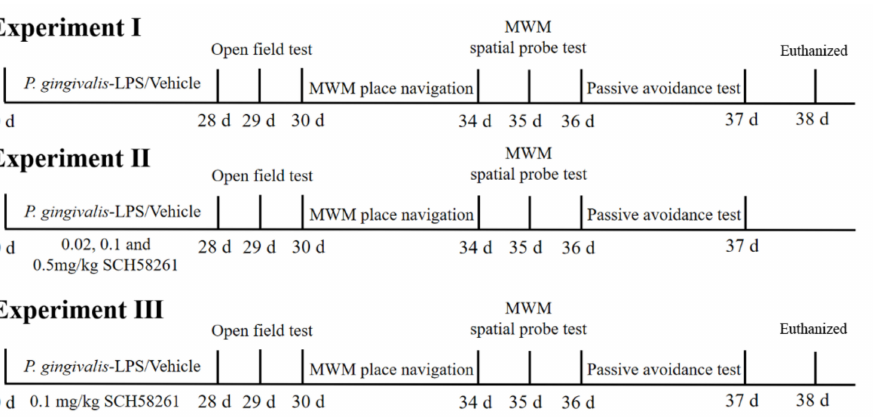
Figure 1. Time-line diagram of study design. Experiment I: P. gingivalis LPS was injected into the palatal gingival sulcus of maxillary first molars twice a week for four weeks at a dose of 0.5 mg/kg to construct CP mice model. OFT, MWM and PAT were performed on the days 29, 30–35, and 36–37 after P. gingivalis LPS administration, respectively. On the day 38, mice were sacrificed for molecular biological detection. Experiment II: the CP mice model was established with P. gingivalis LPS along with daily intraperitoneal injections of SCH58261 (0.02, 0.1 and 0.5 mg/kg) for four weeks. The behavioral tests were the same as Experiment I. Experiment III: the CP mice model was established with P. gingivalis LPS along with daily intraperitoneal injections of SCH58261 (0.1 mg/kg) for four weeks. The behavioral and molecular biological tests were the same as Experiment I. OFT, Open Field Test; MWM, Morris Water Maze; PAT, Passive Avoidance